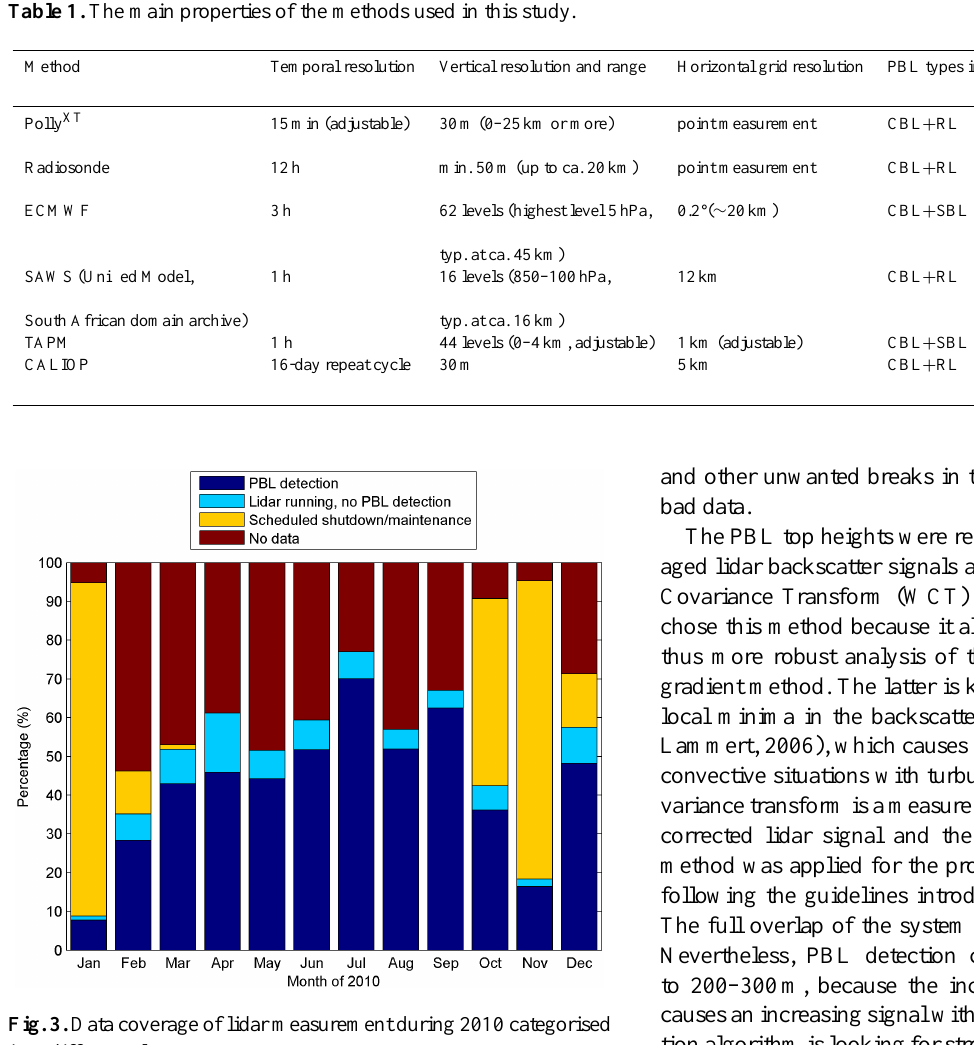
Fig. 3. Data coverage of lidar measurement during 2010 categorised into different